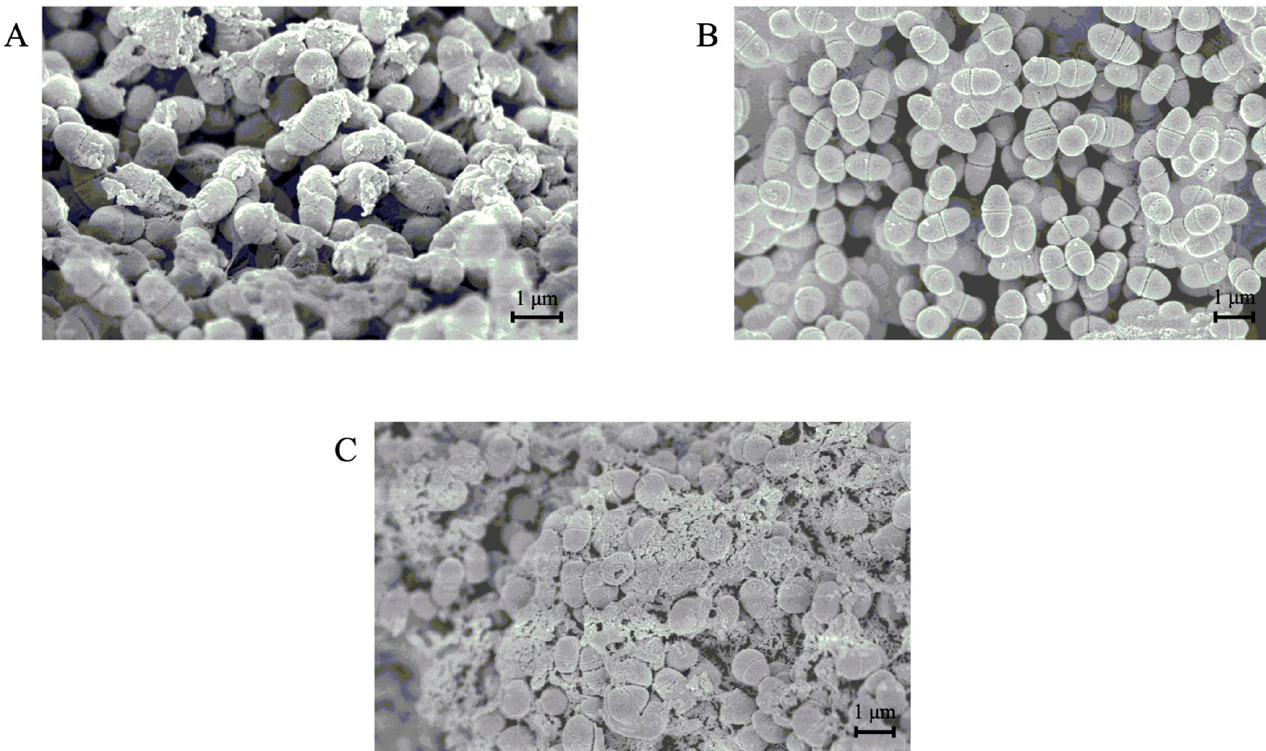
Figure 4. SEM images of S. mutans (magnification 12,000 × ). SEM images were captured after the cultivation of S. mutans in the absence ( A ) or presence ( B ) of a GI fraction. Additionally, the image was captured when S. mutans was cultured in the medium supplemented with an unfermented carrot juice medium ( C ). The observed glucans on the cell surfaces ( A ) were eliminated by adding the GI ( B ), and the unfermented carrot juice medium seemed to enhance glucan production.